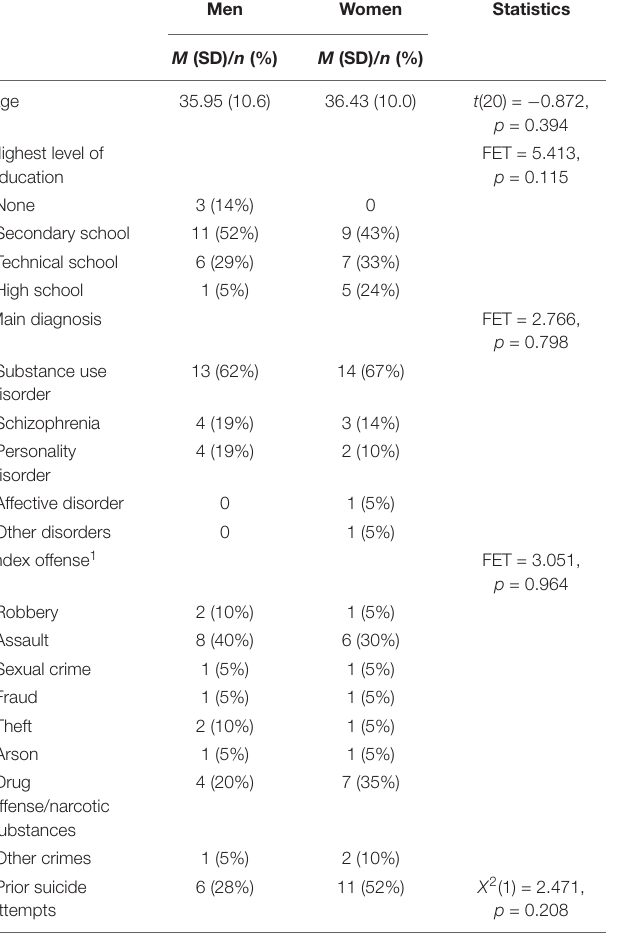
TABLE 1 | Sociodemographic data of an age- and BDI-II score-matched sample of male ( n = 21) and female ( n = 21) forensic psychiatric inpatients.